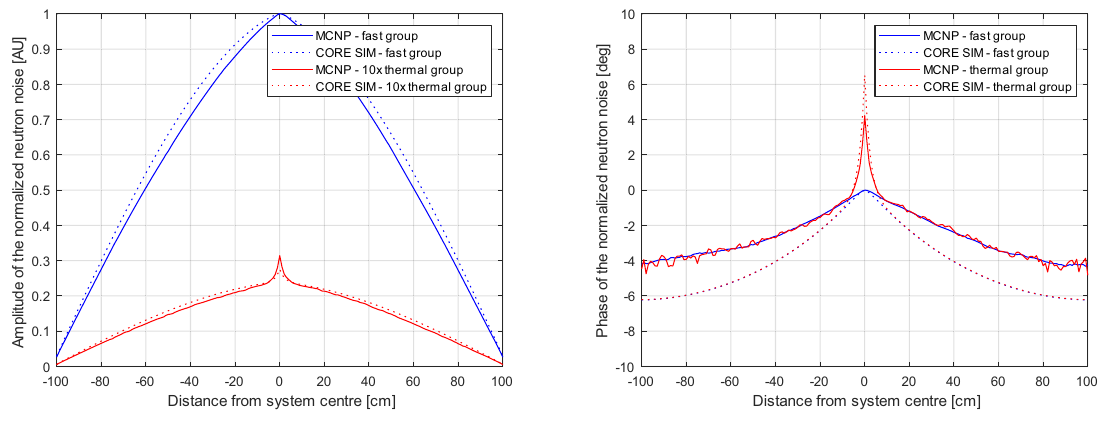
Fig. 2 Results for the homogeneous test case. All results were normalized to the same induced neutron noise in the fast energy group at the location of the noise